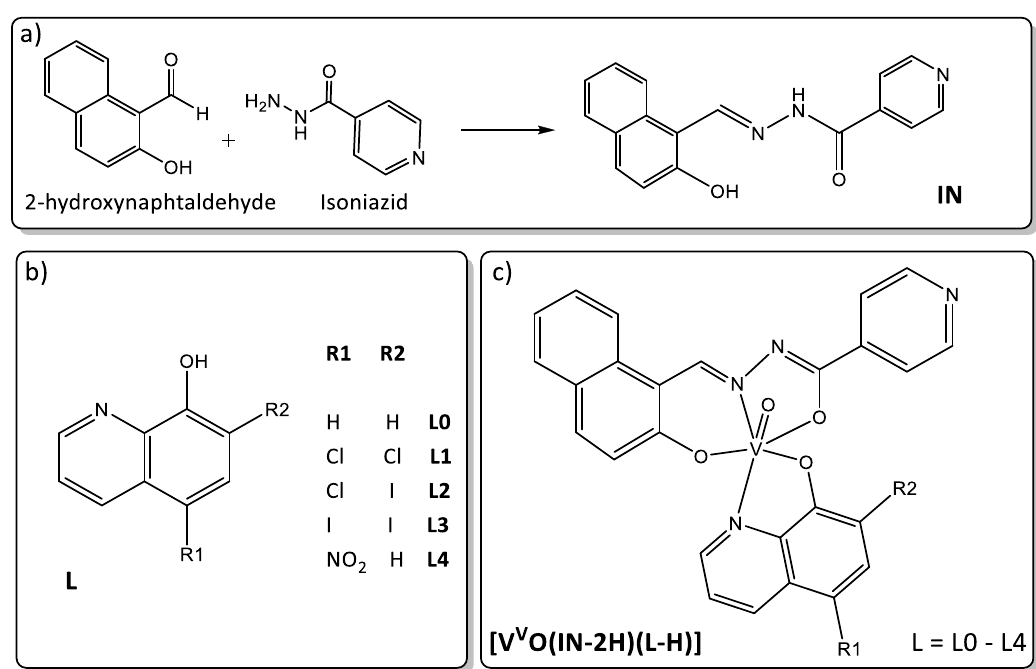
Figure 1. ( a ) Scheme of synthesis of the new IN tridentate ligand; ( b ) structural formulae of the selected 8-hydroxyquinoline derivatives L0–L4; ( c ) molecular structure of the new [V V O(IN-2H)(L-H)] complexes.